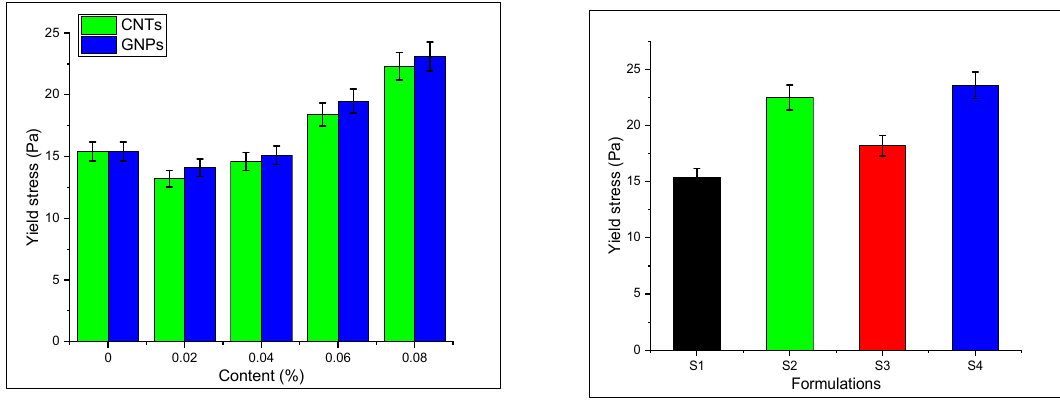
Figure 15. Yield stress of SCCM.